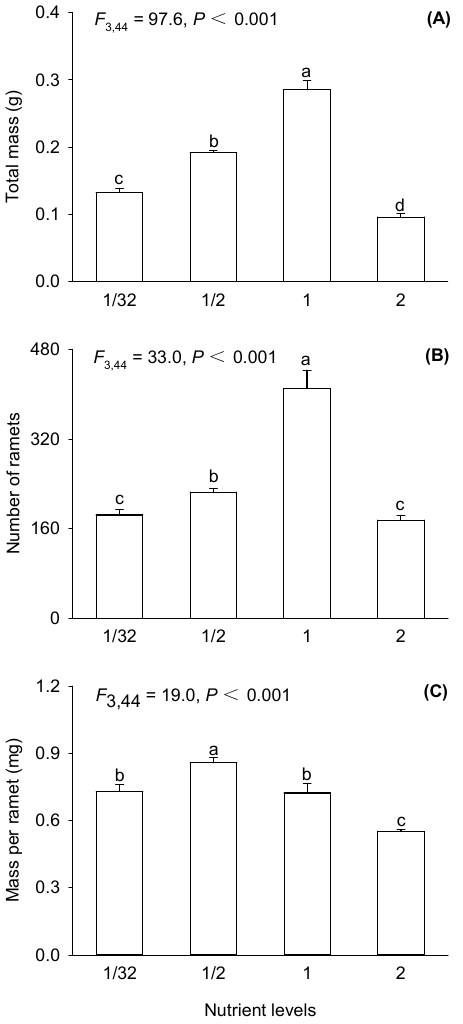
Figure 1. Total mass ( A ) number of ramets ( B ) and mass per ramet ( C ) of Spirodela polyrhiza in response to different nutrient availability for the first phase of Experiment 1. The values are means and standard errors. Different letters indicate significant differences.